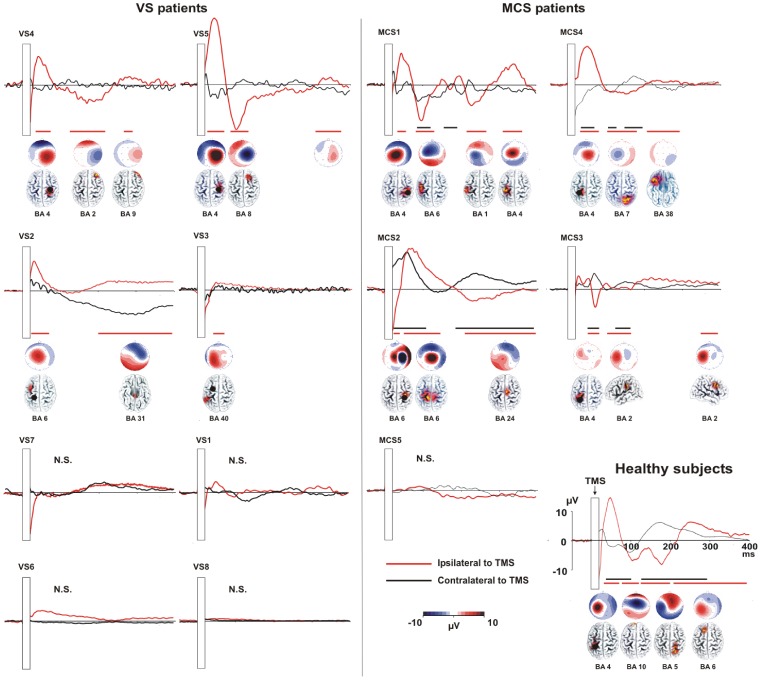
TEPs recorded in VS patients, MCS patients and healthy controls (grand average of five individuals).The figure presents the TEPs recorded from C3 and C4 following stimulation of the left or right M1 in VS (left insert) and MCS patients (right insert). The right lower part of the figure indicates the grand average TEPs obtained in five healthy controls stimulated above the left primary motor cortex (M1; C3). For all patients and the control group, the presented TEPs were recorded from the closest electrode to the hot-spot (ipsilateral to TMS – red line) and from the corresponding electrode on the contralateral hemisphere (black line). The hot-spot is indicated with a black dot. The responses obtained during the sham condition were point-by-point subtracted from those obtained during the real TMS. The significant time-windows (i.e., EEG signal exceeding three times the standard deviation of the pre-stimulus activity for at least 20 ms) are separately indicated for the ipsilateral electrode with a horizontal red line and for the electrodes contralateral to the TMS hot-spot with a black line.